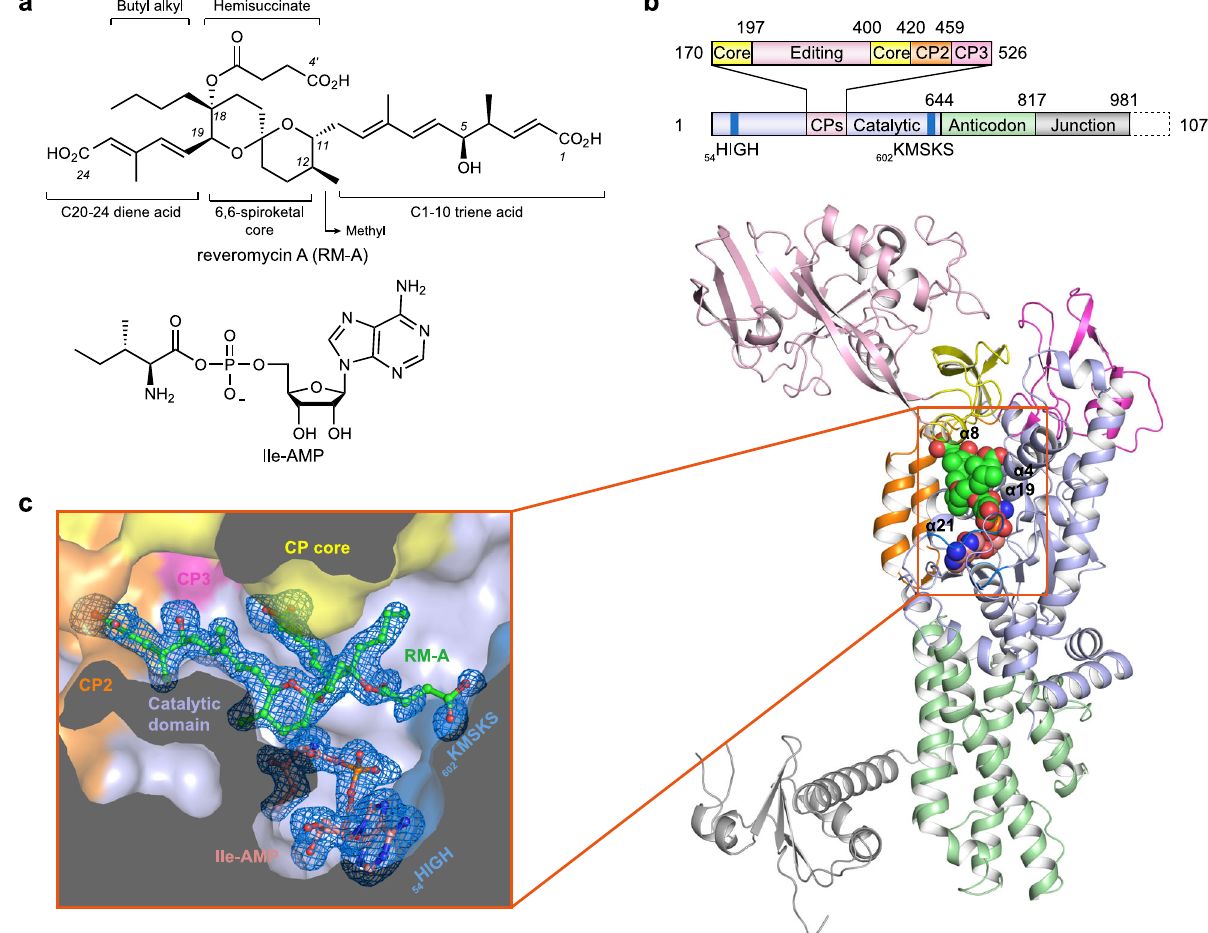
Fig. 1 Structure of Sc IleRS with bound ligands. a Chemical structures of reveromycin A (RM-A) and the intermediate product Ile-AMP. b Overview of the Sc IleRS ∙ RM-A ∙ Ile-AMP complex structure determined at a resolution of 1.9 Å. The residue numbers in the colour-coded diagram indicate domain boundaries. RM-A and Ile-AMP are shown in spherical models. The colour schemes for RM-A (green) and Ile-AMP (salmon) are the same throughout the manuscript. The α -helices forming the binding pocket of RM-A are labelled. c An annealed omit electron density map of RM-A and intermediate Ile-AMP calculated with Fourier coef fi cients F o - F c and contoured at 2.5 σ . RM-A and Ile-AMP co-bind in the aminoacylation pocket of the catalytic